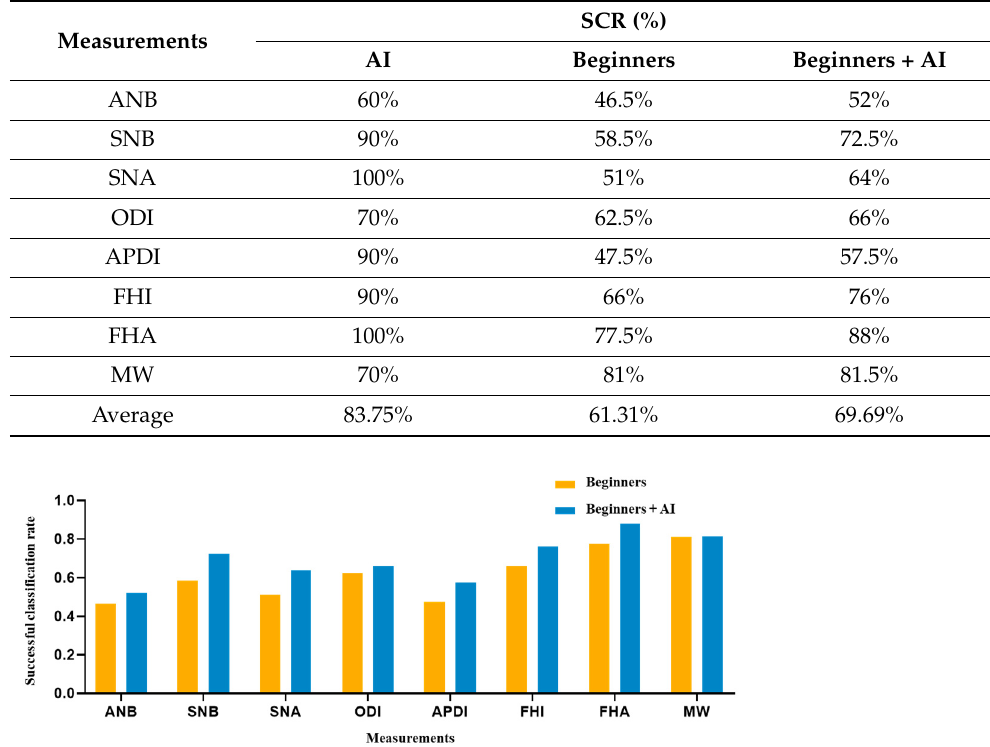
Table 6. Successful classification rate for eight clinical measurements.